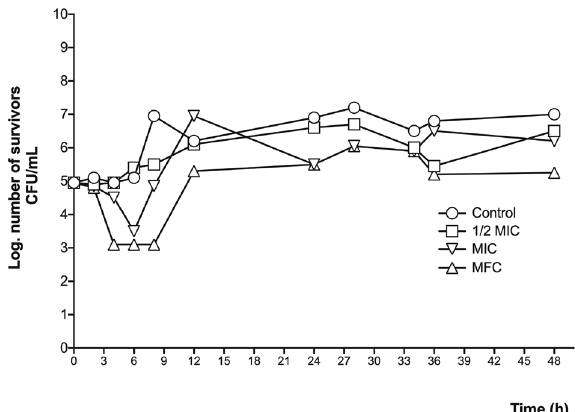
Figure 5. Time-killing fungal kinetic assay of the methanolic leaf extract against the C. tropicalis clinical case. 1/2 MIC = 0.078 mg/mL; MIC = 0.156 mg/mL; MFC = 0.62 mg/mL.